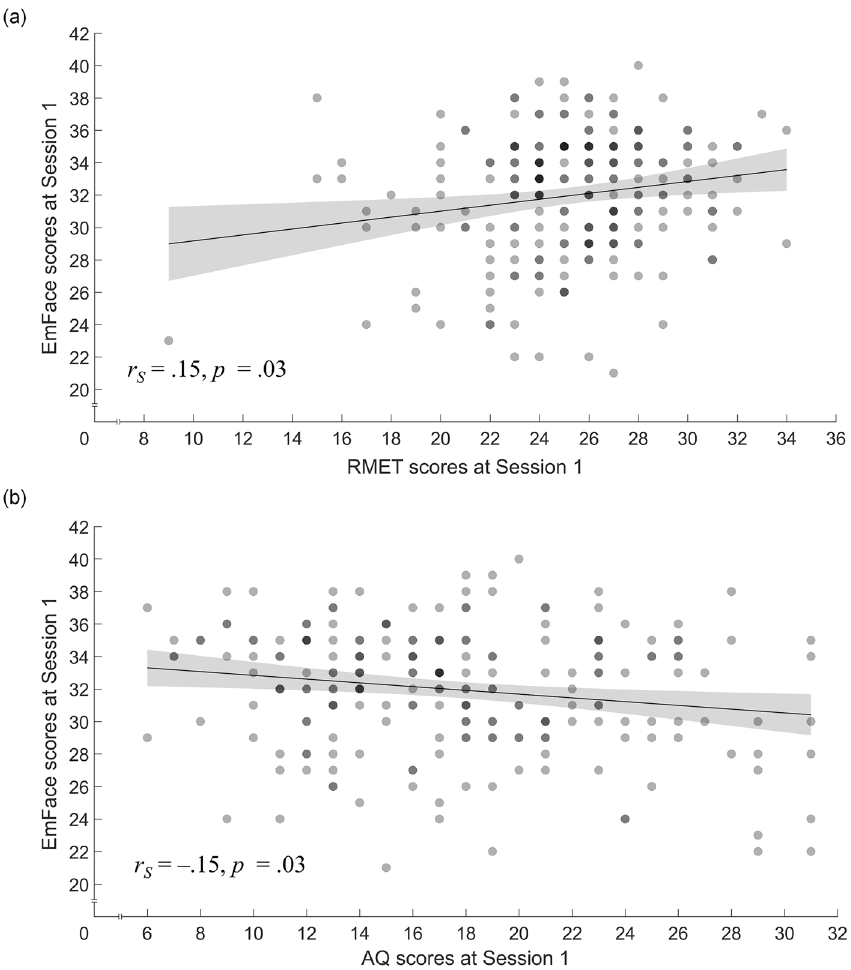
Figure 4. Relationship between the EmFace and ( a ) RMET sum scores and ( b ) AQ sum scores, respectively. Each graph shows a line of best fit and the 95% confidence interval (shaded bands). Dots are semi-transparent so that locations with overlapping data points are